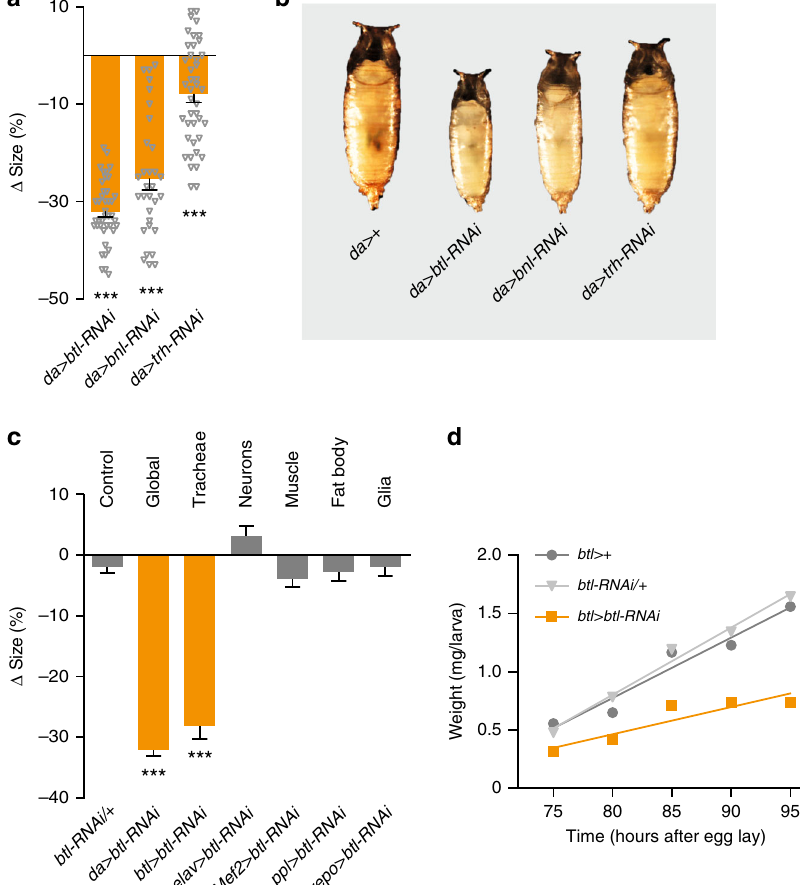
Fig. 2 Tracheal loss of breathless reduces systemic growth and body size. a , b Quanti fi cation of pupal sizes and representative images ( b ) of animals with ubiquitous knockdown of breathless ( btl) -pathway components compared with the controls ( da > + ; da > crossed to wild type, w 1118 ). Values are percent change in pupal size vs. control. a : n = 31 – 64. c Knockdown of btl in whole animals ( da > btl-RNAi ) or tracheae alone ( btl >), but not in neurons ( elav >), muscle ( Mef2 >), fat-body tissue ( ppl >), or glia ( repo >) leads to small animals compared with da > + controls. Shown also is the RNAi control ( btl-RNAi / + ; btl-RNAi crossed to w 1118 ). Values are percent change in pupal size vs. the btl > + controls ( btl > crossed to w 1118 ). n = 33 – 86. d Trachea-speci fi c knockdown of btl reduces larval growth rates compared with driver ( btl > + ) and RNAi controls ( btl-RNAi/ + ). Statistics: one-way ANOVA with Dunnett ’ s multiple- comparisons test. *** P < 0.001, compared with the control. Error bars indicate SEM. Underlying data are provided in the Source Data fi (Fig. 4b, c), implying a reduced oxygen supply. In btl > btl-RNAi